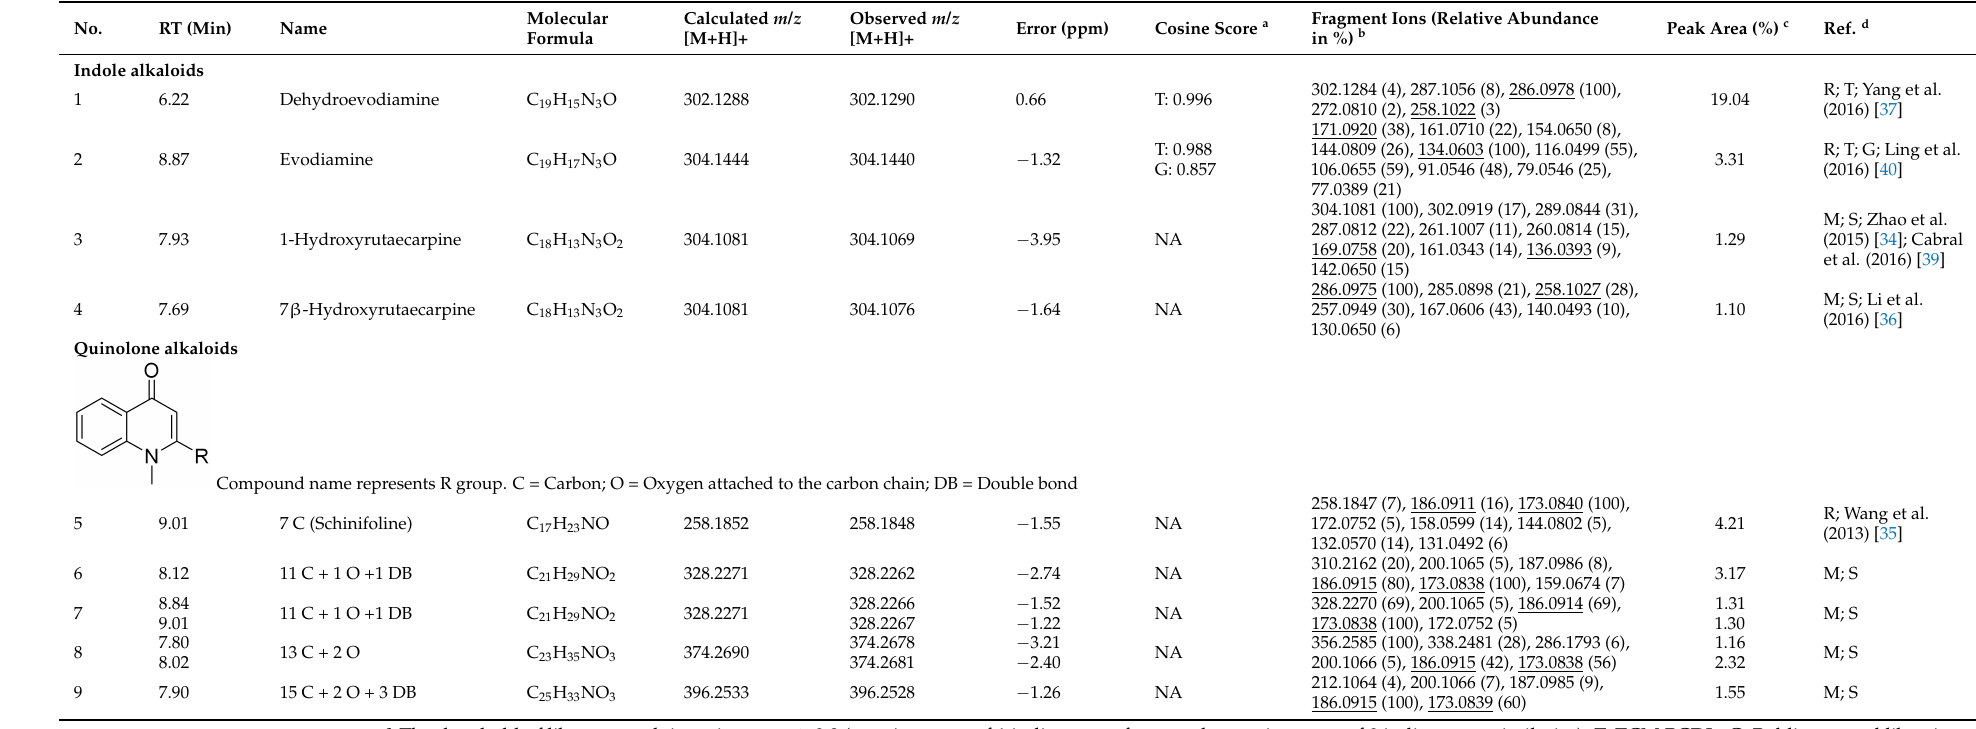
Table 2. Characteristic compounds of the EtOAc fraction F2-3 of T. ruticarpum fruit in the targeted molecular families containing indole alkaloids and quinolone